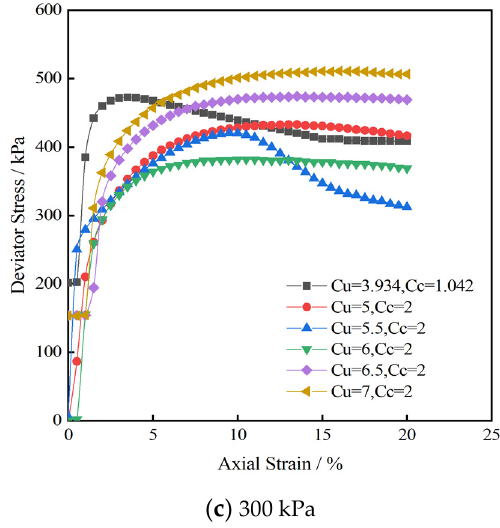
Figure 14. Stress–strain curves of tailings sand corresponding to different C u .